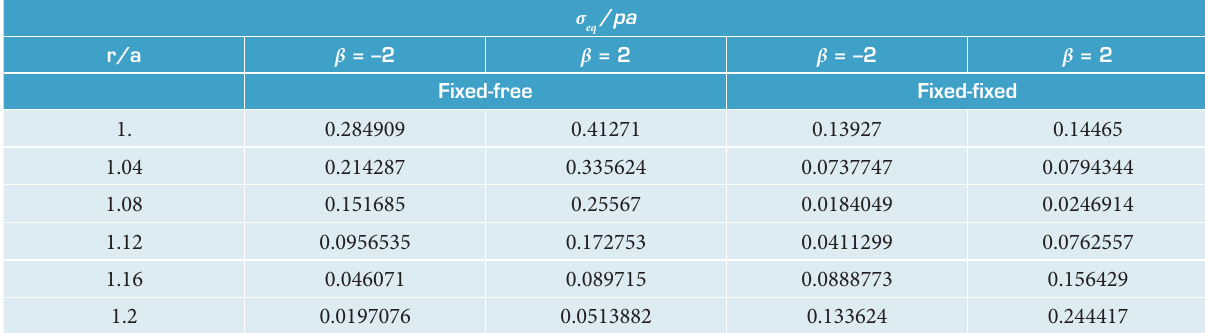
Table 2. Variation of the dimensionless equivalent stress under individual and combined loads for mounted rotating disks and β = 2, –